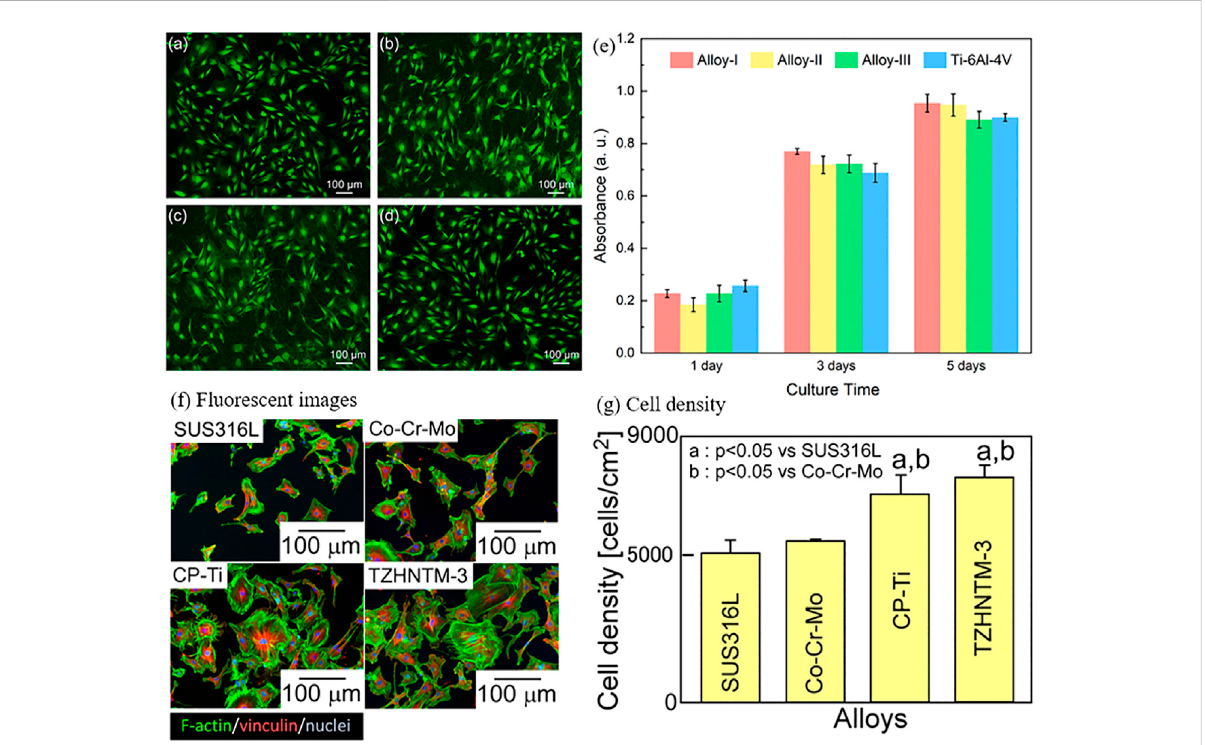
FIGURE 14 Live/deadstainingofMC3T3-E1cellson (A) Alloy-I, (B) Alloy-II, (C) Alloy-III,and (D) Ti64after72 hofincubation. (E) TheproliferationofMC3T3- E1cellsonAlloy-I,Alloy-II,Alloy-III,andTi64after1,3,and5daysofcellculture,respectively(YangW.etal.,2022).Biocompatibilityofthearc-melted isoatomic TiNbTaZrMo (TZHNTM-Eq) and non-isoatomic Ti 28.32 Zr 28.32 Hf 28.32 Nb 6.74 Ta 6.74 Mo 1.55 (TZHNTM-3) and SUS316L stainless steel, ASTM F1537-08 of Co-Cr-Mo alloy and commercially pure titanium (CP-Ti) were used as references. (F) Quantitative analysis of the density of osteoblasts cultured on the fabricated specimens by staining images with Giemsa and (G) fl uorescent images of osteoblast adhesion on the fabricated specimens (Iijima et al.,